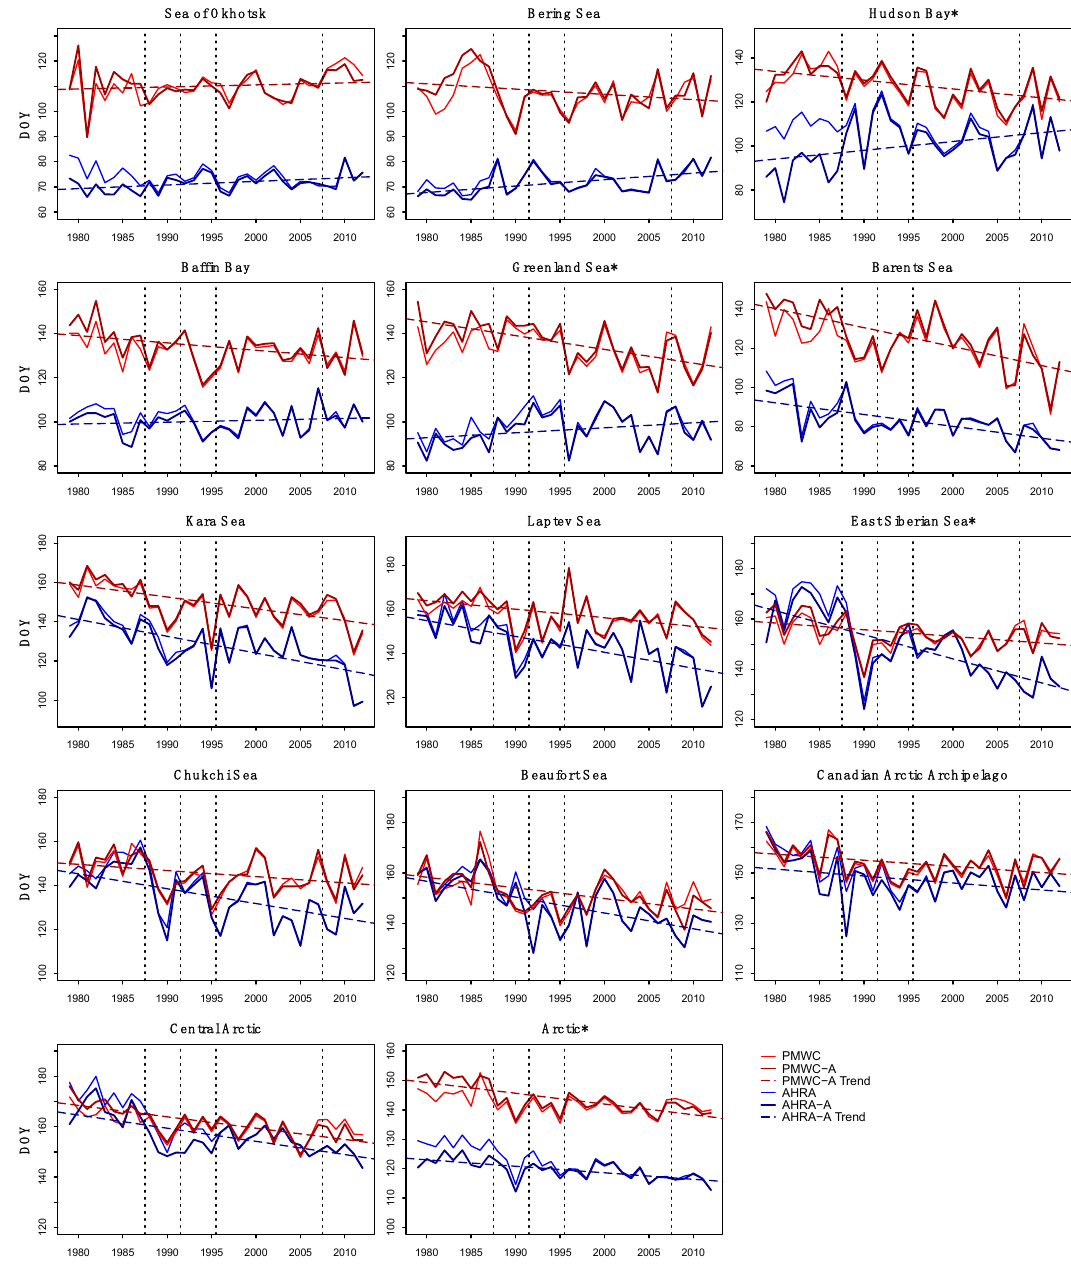
Figure 8. Annual mean MO date (DOY) for the AHRA-A and PMWC-A methods for 1979–2012. Least squares linear regression trends are shown as dashed lines. Original mean MO dates from the AHRA and PMWC methods (shown in Figure 7) are included here for comparison. Vertical dotted lines indicate when changes in passive microwave satellite sensors occur. Trends are significantly different at the 95% confidence level based on a Student’s t -test in regions indicated with an asterisk. While the average offsets between the original and adjusted MO dates increase slightly, the change in trend can be significant. When using PMWC-A data, the number of regions with statistically significant trends in mean MO date within the Arctic Ocean increases from three to eight (Table 3). The magnitude of the negative regional trends obtained with the PMWC-A is generally smaller than the AHRA-A trends (Table 3); however, the adjusted trends are now statistically significant for all regions except the Okhotsk and Bering Sea regions (Table 3). The statistically significant negative